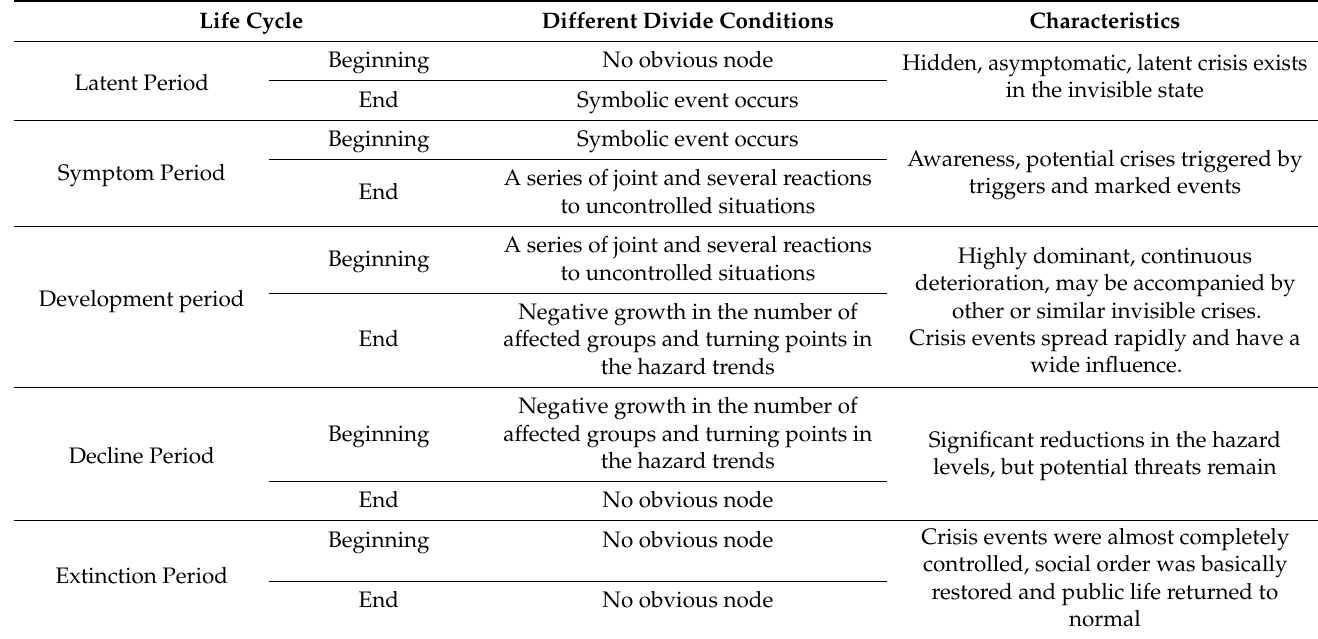
Table 2. Standard for the Period Division Based on